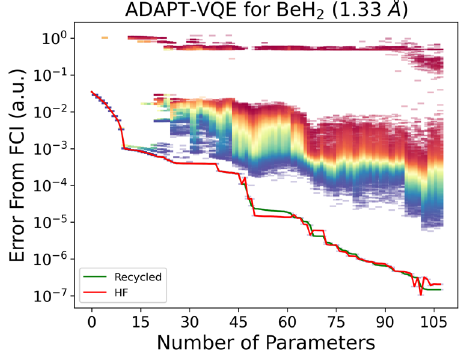
Fig. 5 ADAPT-VQE results for BeH 2 at 1.33 Å . The axes and colors are as in Fig. 1.